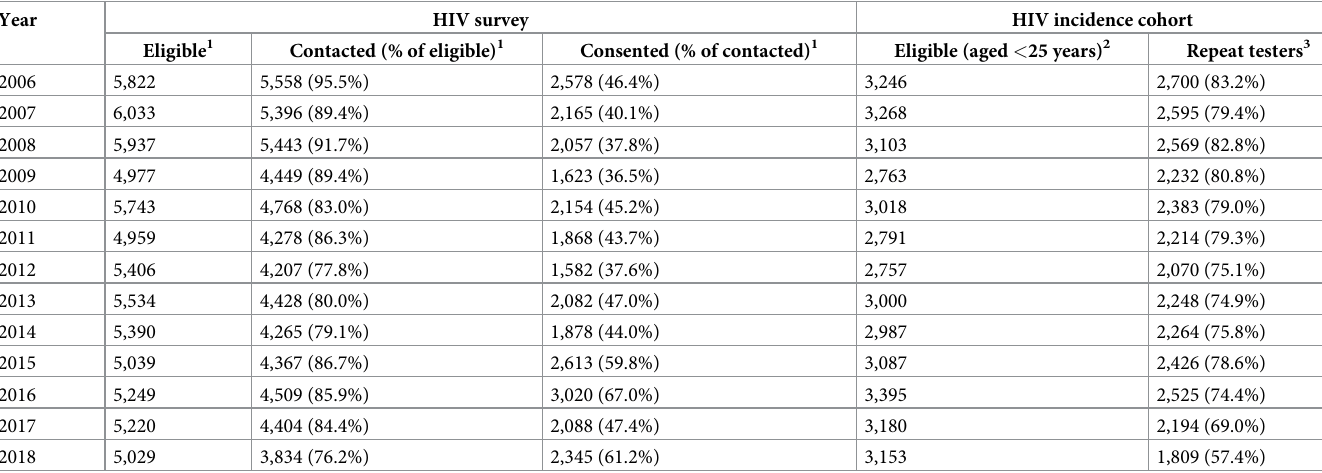
Table 1. Testing participation in HIV serosurveys among AGYW and contribution to HIV incidence cohort in uMkhanyakude, South